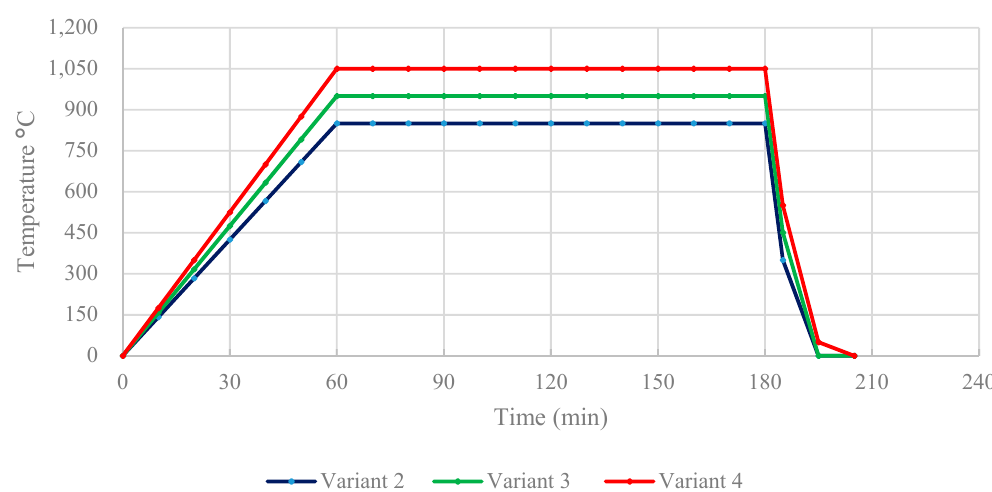
Figure 2. Comparison of different Hot Isostatic Pressing (HIP) cycles for Ti6242 specimens.